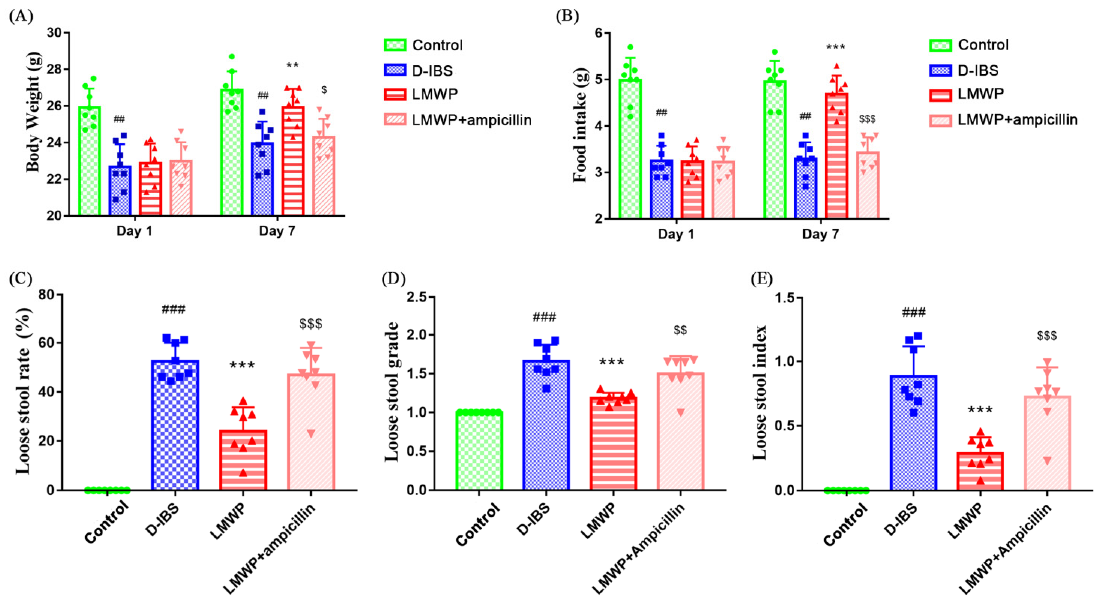
Figure 2. LMWP (S3-3) from the larvae of Musca domestica affects body weight, food intake and diarrhea in D-IBS mice. ( A ) Body weight on day 1 and day 7 in the treatment period. ( B ) Food intake on day 1 and day 7 in the treatment period. ( C – E ) Loose stool rate, loose stool grade and loose stool index. Values are presented as means ± SD ( n = 8). ## p < 0.01 and ### p < 0.001 compared with Control, ** p < 0.01 and *** p < 0.001 compared with D-IBS, $ p < 0.05, $$ p < 0.01 and $$$ p < 0.001